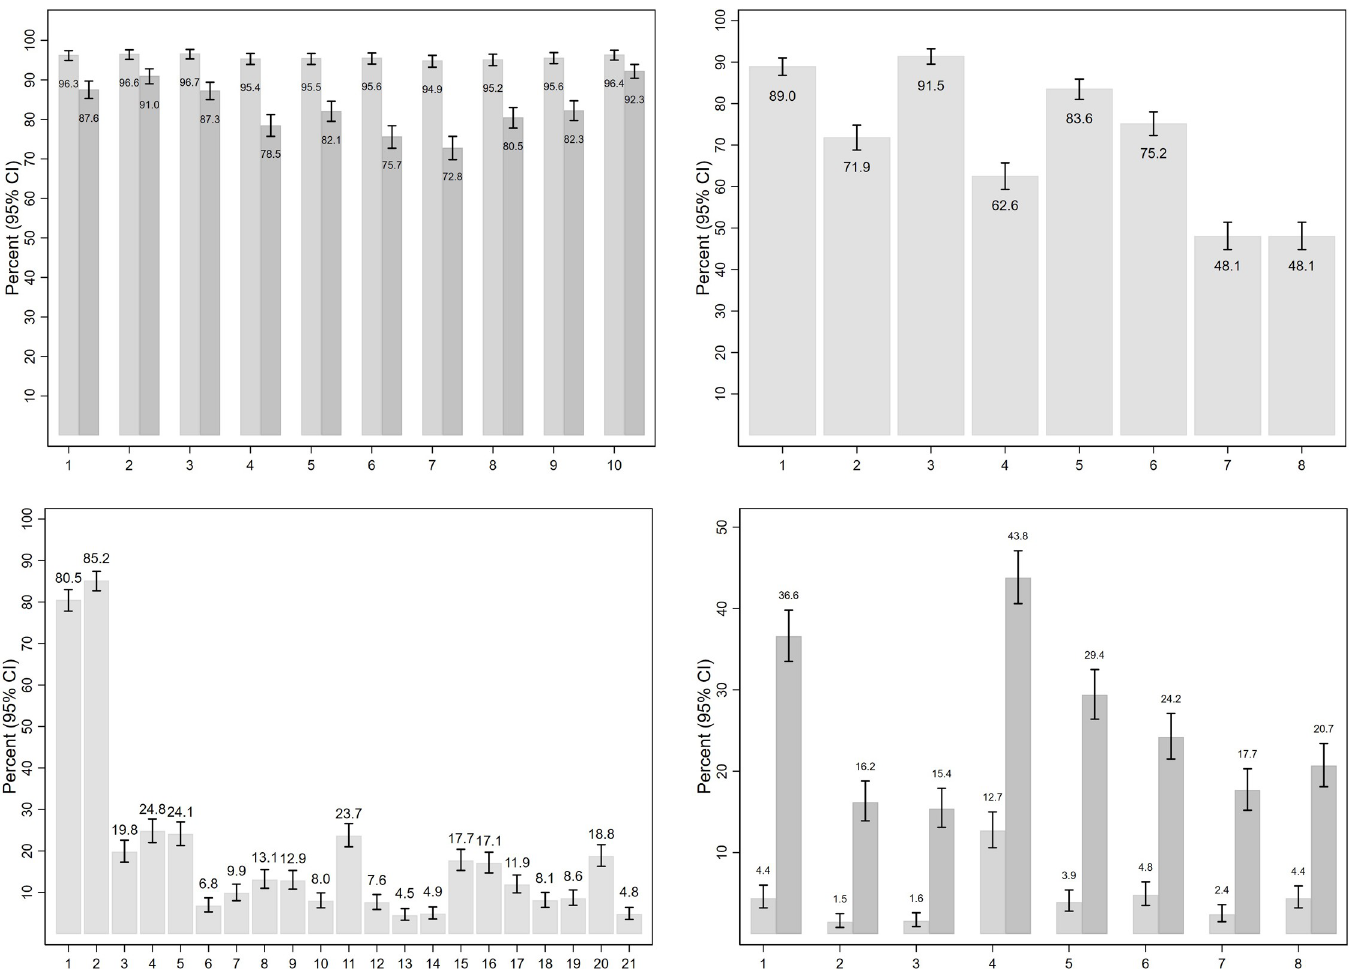
Fig 1. A. Responses to individual items on knowledge of FDV behaviours (total sample, weighted data). Do you consider the following behaviours to be family and domestic violence? When a person: 1 Slaps or pushes their partner to cause harm or fear; 2 Tries to scare or control their partner by threatening to hurt other family members; 3 Throws or smashes objects near their partner to frighten or threaten them; 4 Repeatedly criticises their partner to make them feel bad or useless; 5 Controls their partner’s social life by preventing them from seeing family and friends; 6 Tries to control their partner by denying them money; 7 Repeatedly keeps track of their partner or former partner’s location, calls or activities; 8 Repeatedly follows or watches a partner or former partner; 9 Repeatedly sends partner or former partner unwanted phone calls, emails, text messages and the like; 10 Forces their partner to have sex. Lighter grey shade: respondent considers that the behaviour is sometimes/ usually/always FVD. Darker grey shade: respondent considers that the behaviour is always FVD. Proportions and 95% confidence intervals were estimated with Fisher’s exact test, then converted to percentage values. B. Responses to individual items on knowledge of FDV causes–percent of respondents who Agree or Strongly Agree that the item is a cause (total sample, weighted data). How much do you agree or disagree that the following cause family and domestic violence? 1 Alcohol; 2 Lack of employment; 3 Use of illegal drugs; 4 Men’s loss of role and status; 5 Men wanting to control women; 6 Violence in the community; 7 Violence in the media (movies, video games etc.); 8 Pornography. Proportions and 95% confidence intervals were estimated with Fisher’s exact test, then converted to percentage values. C. Responses to individual items on attitudes towards FDV (total sample, weighted data)–percent who Agree or Strongly agree with each attitude. How much do you agree or disagree with the following statements? 1 I would tell a male friend when his behaviour is sexist; 2 If I saw a male friend insulting or verbally abusing a woman he is in a relationship with I would do or say something to show I didn’t approve; 3 If a person hits you, you should hit them back; 4 It is okay to hit children if they have